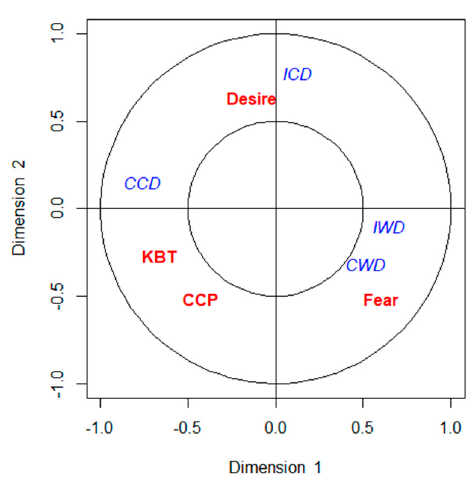
Figure 3. The canonical loadings for correct and incorrect crossing decisions ( CCD, ICD ) , correct and incorrect waiting decisions ( CWD, IWD ), car creation probability (CCP), fear, desire, and knowledge base transfer (KBT) in Dimension 1 (Canonical Variate 1) and Dimension 2 (Canonical Variate 2).